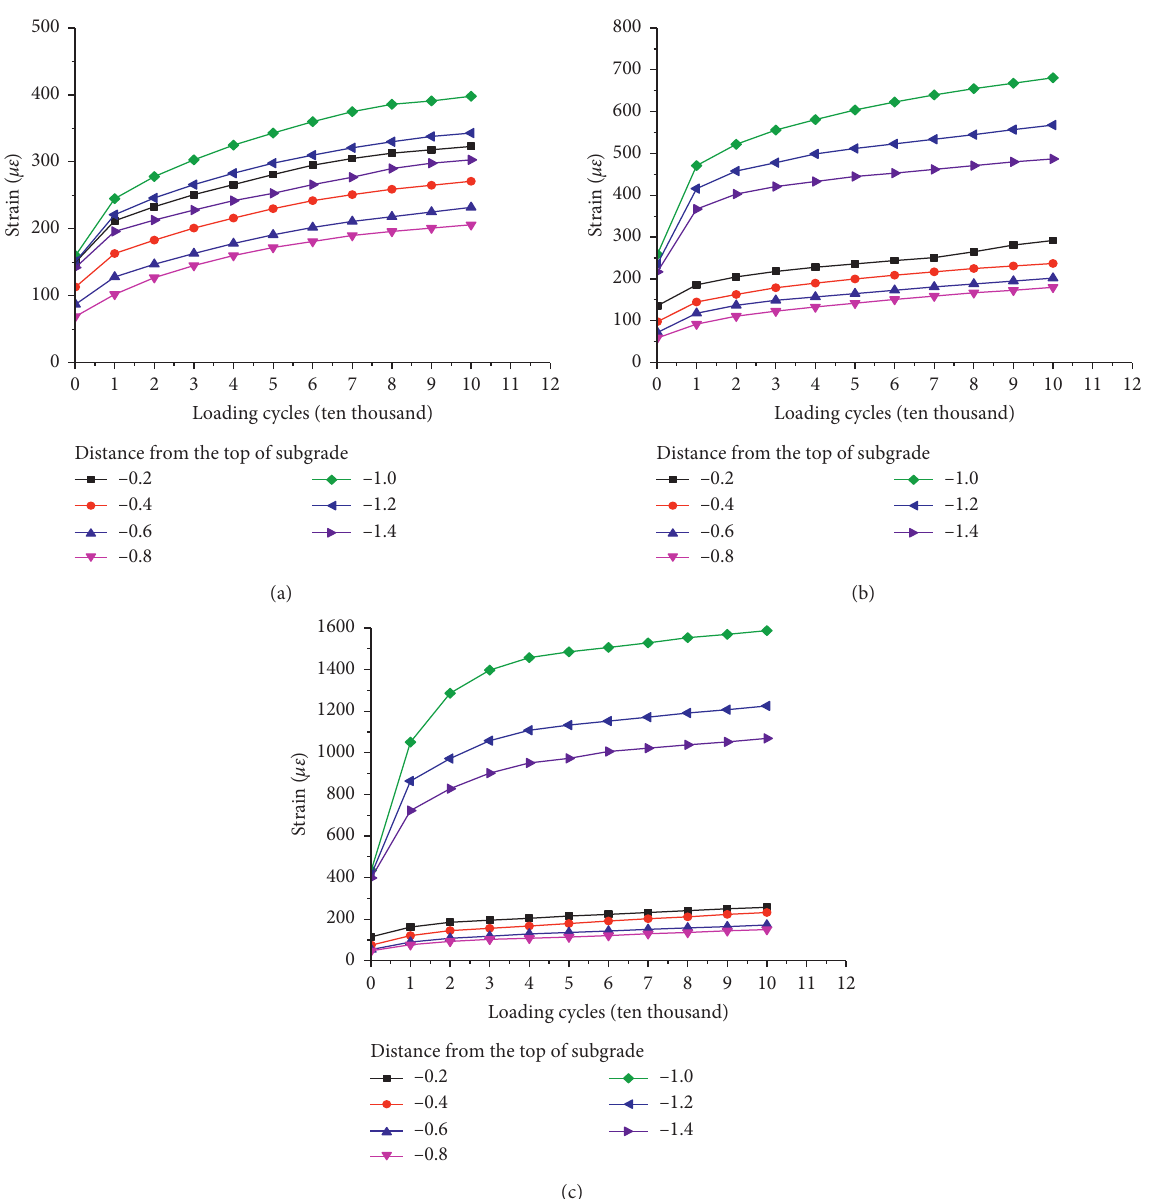
Figure 6: The relationship between the strains of different structural layers and loading cycles. (a) The moisture content of the foundation was 18%. (b) The moisture content of the foundation was 23%. (c) The moisture content of the foundation was